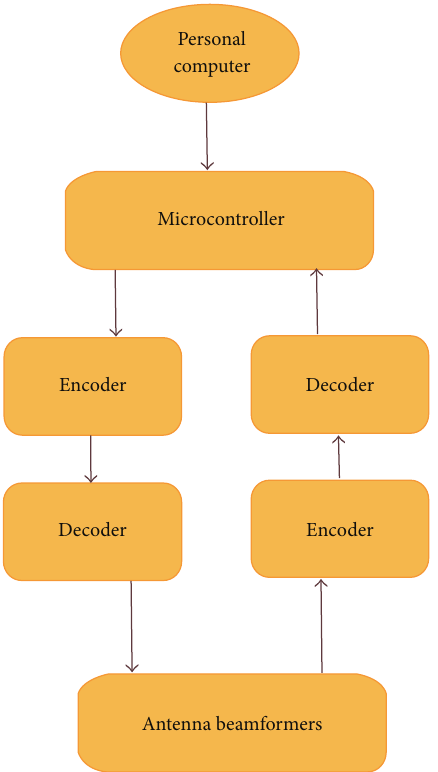
Figure 3: Block diagram of the remote control system for the active array.